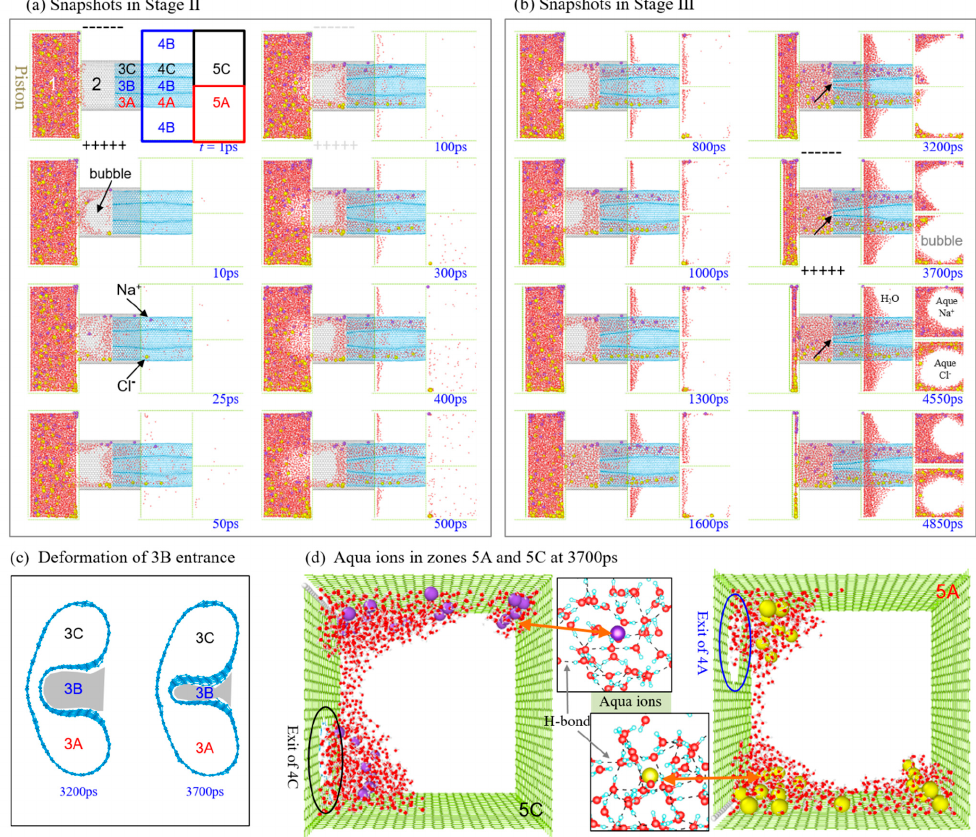
Figure 5. Motion of the solution via the A-30 CTT as subchannels at 300 K when E EF = 6.9 V/Å and C NaCl = 0.6 mol/L. ( a ) Snapshots in Stage II (just open the valve), ( b ) snapshots in Stage III (push the piston at the speed of v ). The black arrows indicate the entrance of Ω 3B . ( c ) Choked entrance of Ω 3B due to large deformation. ( d ) Aqua ion distribution in Ω 5A and Ω 5C at 3700 ps.